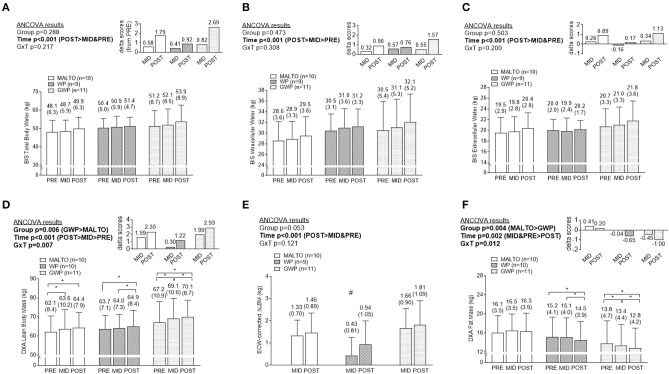
Body composition differences between supplementation groups. Only significant time effects were observed for total body water content (A) assessed via bioelectrical impedance spectroscopy (BIS), BIS intracellular water content (B), and BIS extracellular water content (C). For all of these metrics, POST values were significantly greater than PRE and MID values. Significant main group and time effects as well as a group × time interaction were observed for lean body mass (D) assessed via dual x-ray absorptiometry (DXA). Post-hoc tests indicated lean body mass increased within groups from PRE to MID (MALTO and GWP; *p < 0.05), MID to POST (WP abd GWP; *p < 0.05), and PRE to POST (all groups; *p < 0.05). However, no significant between-group differences existed at each level of time. A significant main time effect as well as a group × time interaction was observed for change scores in DXA lean body mass corrected for change scores in ECW (E). Post-hoc tests indicated this metric increased within groups from PRE to MID (MALTO and GWP; *p < 0.05), and PRE to POST (all groups; *p < 0.05). Additionally, MID WP was significantly lower than MID GWP (#p = 0.004). Significant main group and time effects as well as a group × time interaction were observed for fat mass (F) assessed via DXA. Post-hoc tests indicated fat mass decreased within groups from PRE to MID (GWP; *p < 0.05), MID to POST (WP and GWP; *p < 0.05), and PRE to POST (WP and GWP; *p < 0.05). However, no significant between-group differences existed at any level of time. All data are presented as means ± standard deviation values, and values are indicated above each bar. Additionally, each data panel (except E) has delta values from PRE included as inset data. MALTO, maltodextrin group; WP, standardized whey protein group; GWP, graded whey protein group.